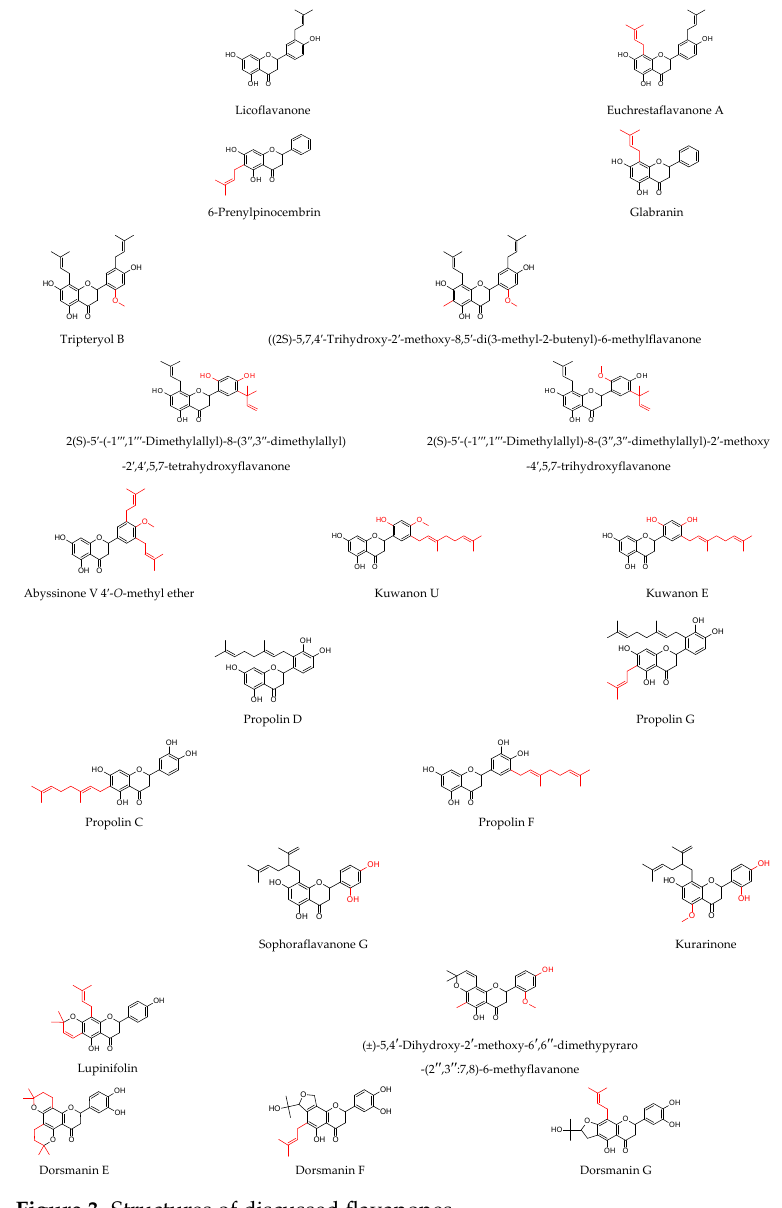
Figure 3. Structures of discussed flavanones.